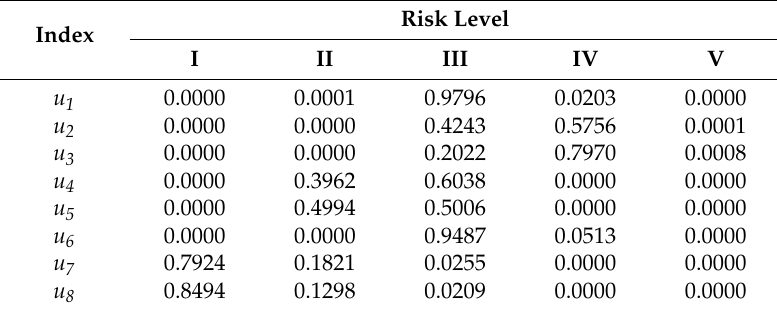
Table 17. Certainty degrees of AP of south Guizhou.